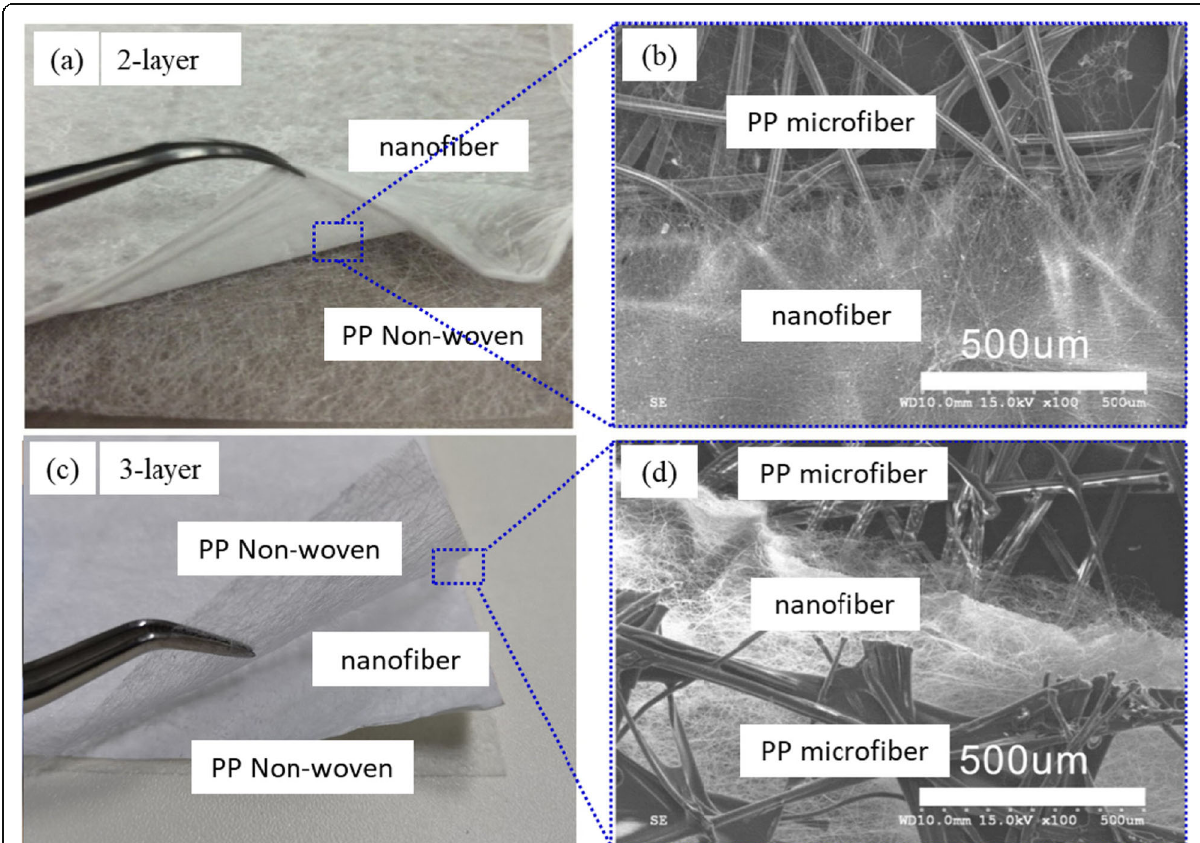
Fig. 1 Morphology of PAN:TiO 2 and PAN-co-PMA:TiO 2 nanofiber membrane composited with PP non-woven air filter (layers): optical photograph of nanofiber membranes of 2-layer ( a ) and 3-layer ( c ), and their enlarged top-views ( c , d ),